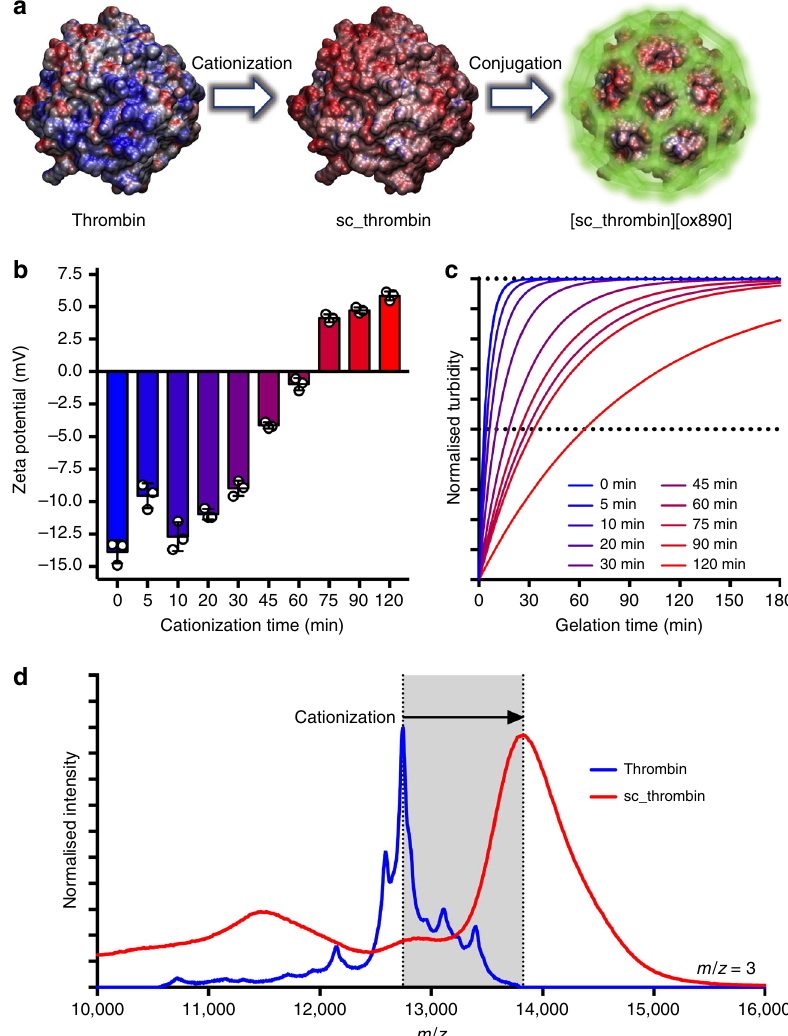
Fig. 2 The synthesis and characterisation of the supercationic thrombin-polymer surfactant conjugate. a Schematic showing the electrostatic surface potential of native and supercationic thrombin (sc_thrombin) (PDB; 1UVS ) at pH 7, highlighting the anionic (blue) and cationic (red) charged regions. Generation of the polymer surfactant corona (green halo) via electrostatic coupling of glycolic acid ethoxylate 4-nonylphenyl ether (ox890) to sc_thrombin gives [sc_thrombin][ox890]. b Zeta potential (ca. pH7; n = 3) of thrombin as a function of cationization times (0 – 120 min). Data reported as means